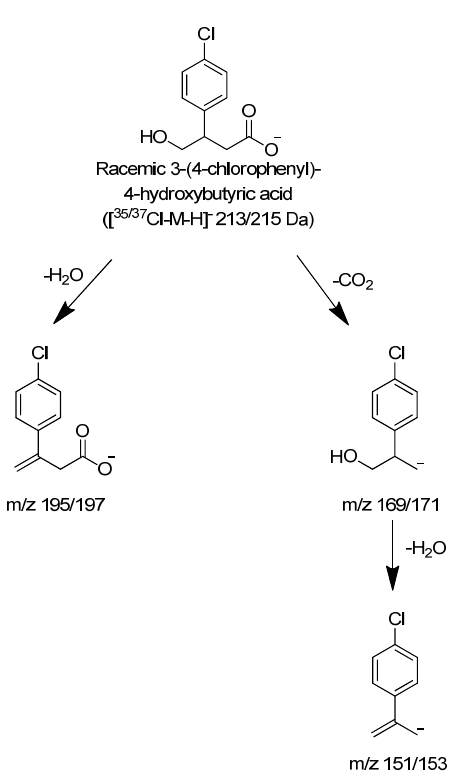
Figure 6. Proposed characteristic ( − )CID-MS/MS fragmentations for (±)-3-(4-chlorophenyl)- 4-hydroxybutyric